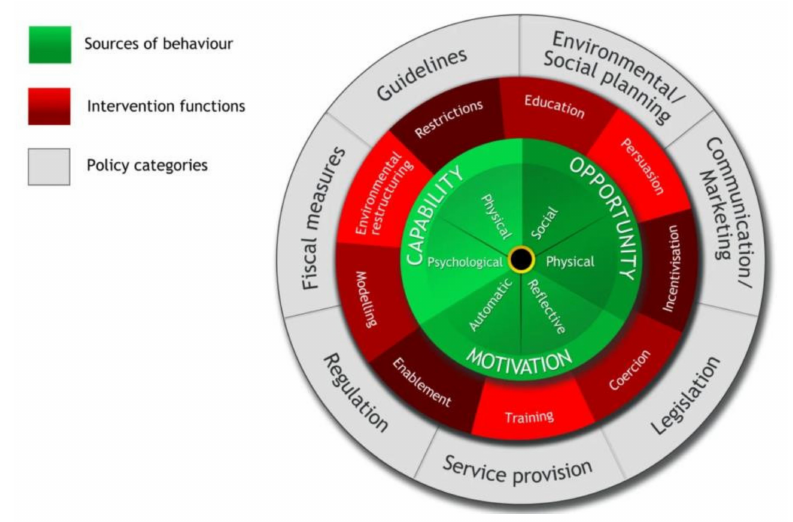
Figure 5. The behaviour change wheel framework